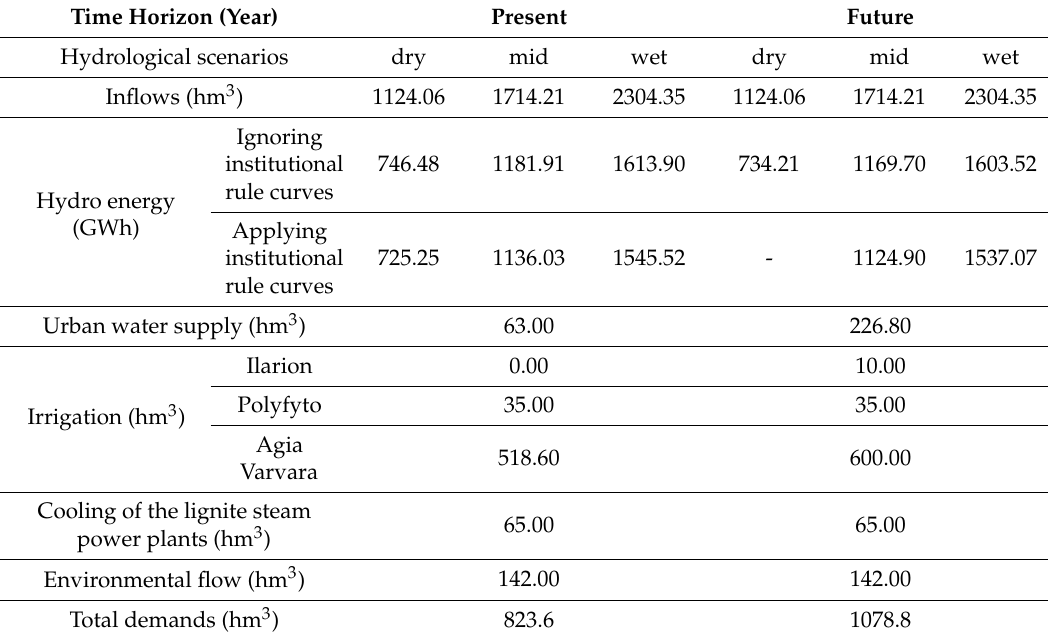
Table 4. Optimization results for the operation of the Aliakmon multi-reservoir system with current and future water demands, ignoring and applying the institutional rule